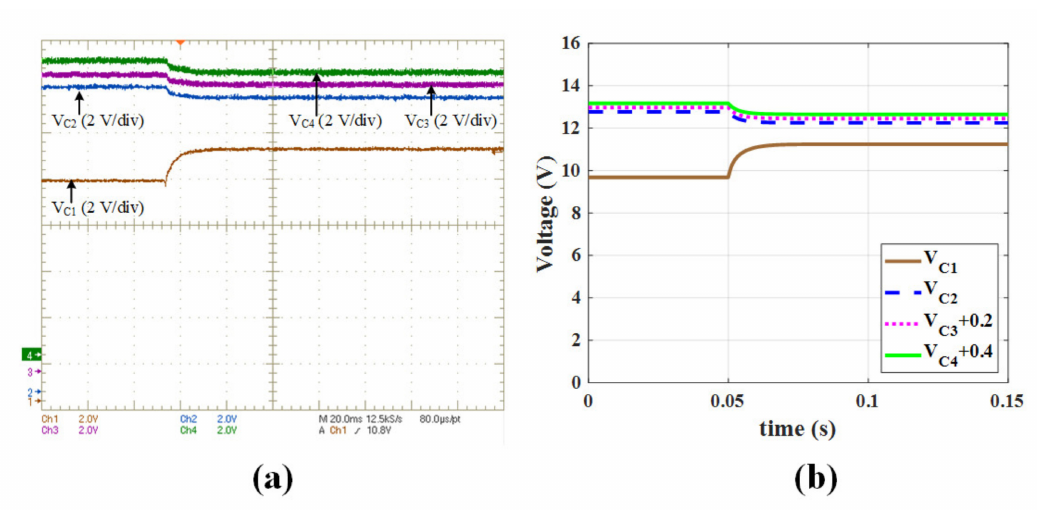
Figure 13. Voltage changes of the boost converters output capacitors connected to the stacks in closed-loop when P 1 is increased from 63 to 100 W, and P 2 is set to the nominal power: ( a ) Experimental results; ( b ) Simulation results of the average model.